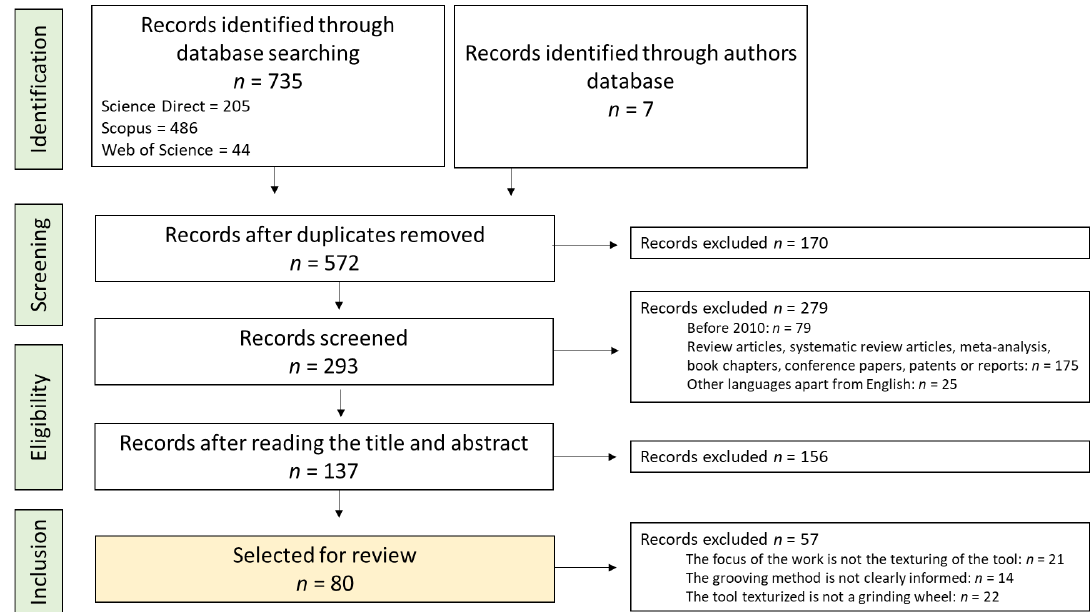
Figure 1. PRISMA flow diagram of the study selection process.